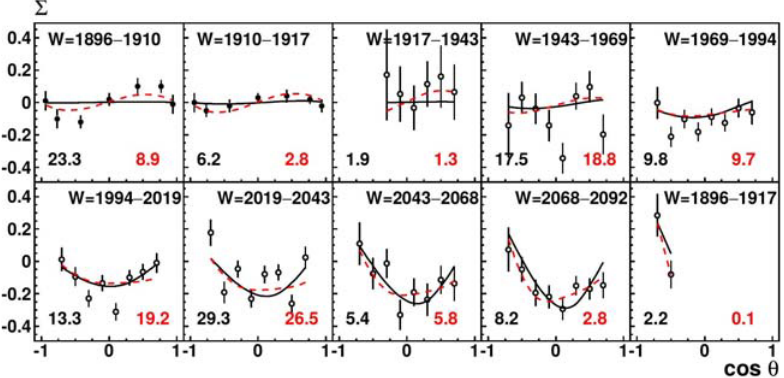
Figure 2. Partial wave analysis results from the Bonn-Gatchina partial wave analysis group. The red dotted lines show the fits with a narrow resonance close to the η (cid:2) threshold included whereas the solid black lines show the same fits without the resonance included [3].